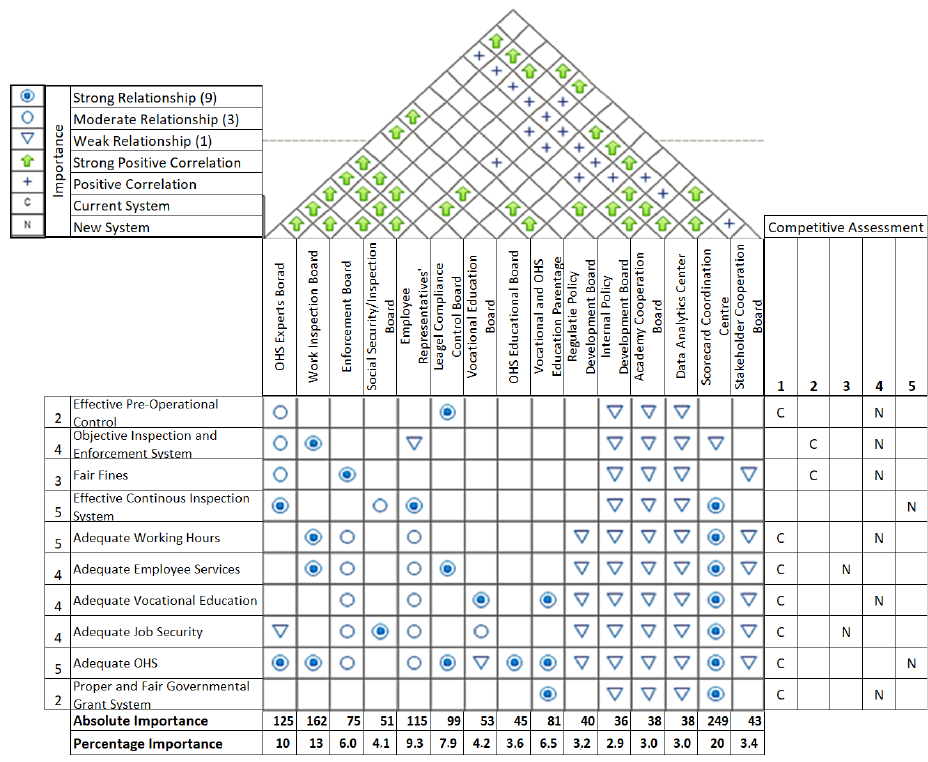
Figure 6. Quality Function Deployment Canvas (House of Quality).